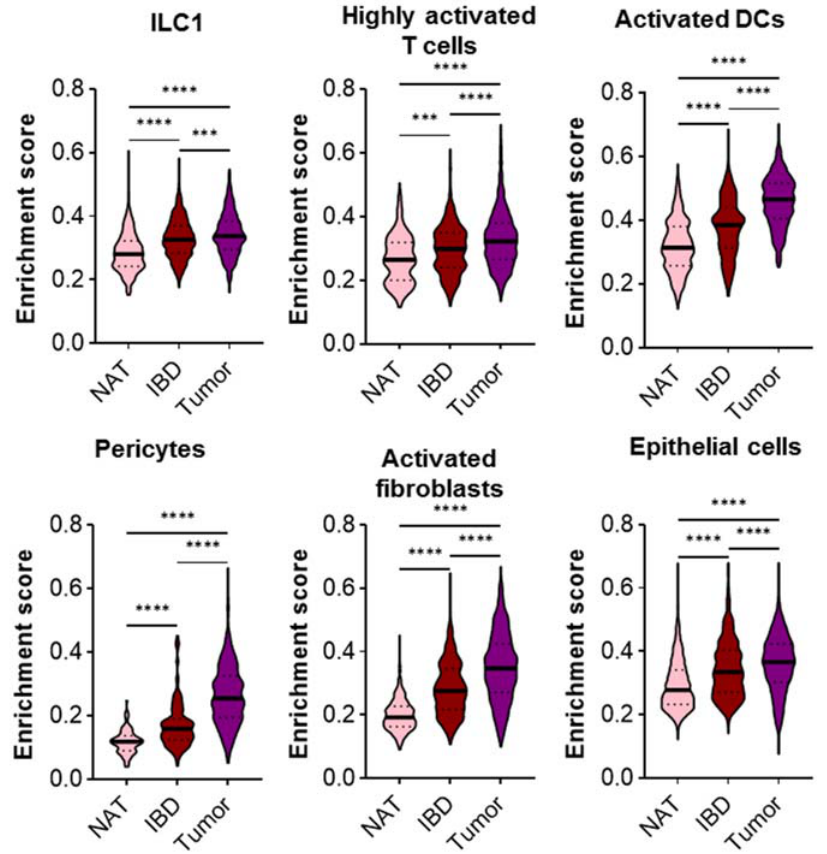
Figure 6. Enrichment of CD risk genes along control, inflammatory and finally tumorous state. After integration and harmonization, the CD and CRC scRNA-seq datasets [15,26] were normalized and scaled together, and an enrichment of CD risk genes was performed. ILC1, highly activated T cells and dendritic cells, pericytes and activated fibroblasts, as well as epithelial cells, displayed a significant upregulation during inflammation, as well as CRC. Kruskal–Wallis test with correction for multiple comparisons by Dunn’s test, α = 0.05. *** p < 0.001, **** p < 0.0001.